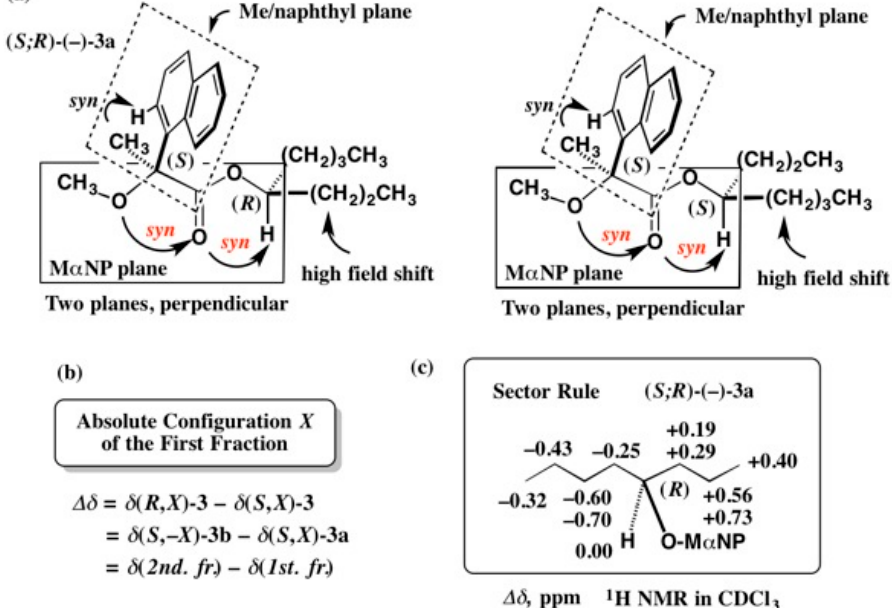
Figure 3. Determination of absolute configurations of 4-octanol M α NP esters ( − )- 3a and ( − )- 3b by 1 H-NMR diamagnetic anisotropy: ( a ) Preferred conformations; ( b ) Definition of ∆ δ value; ( c ) Sector rule. Redrawn with permission from [13].